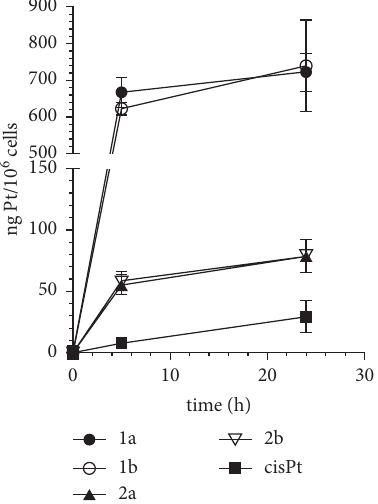
Figure 3: Cellular accumulation of Pt in MDA-MB-231 cells treated for 5h and 24h with the investigated Pt complexes.